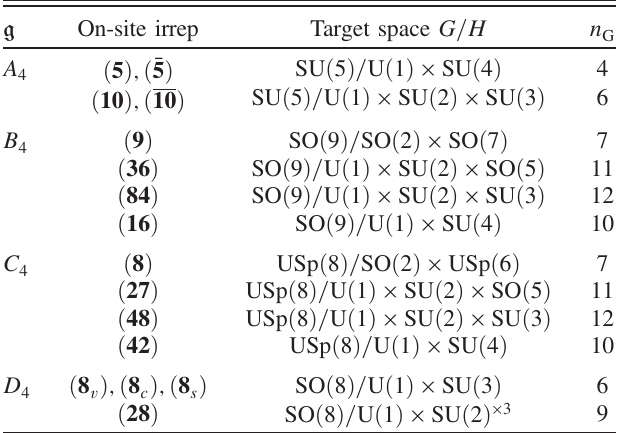
TABLE III. Coset spaces for all the fundamental representa- tions Λ ¼ ω for classical Lie algebras of rank a